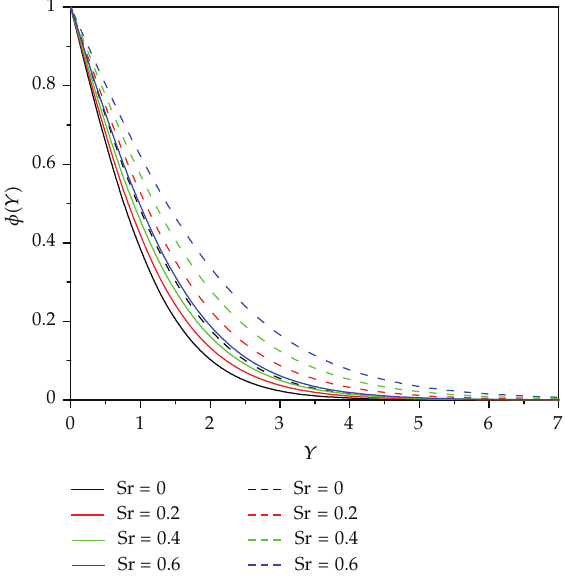
Figure 6: E ff ect of Sr on φ (cid:3) Y (cid:4) with D f (cid:10) 0 . 3, λ (cid:10) − 0 . 5 (cid:3) dashed lines (cid:4) , and λ (cid:10) 0 . 5 (cid:3) solid lines (cid:4)